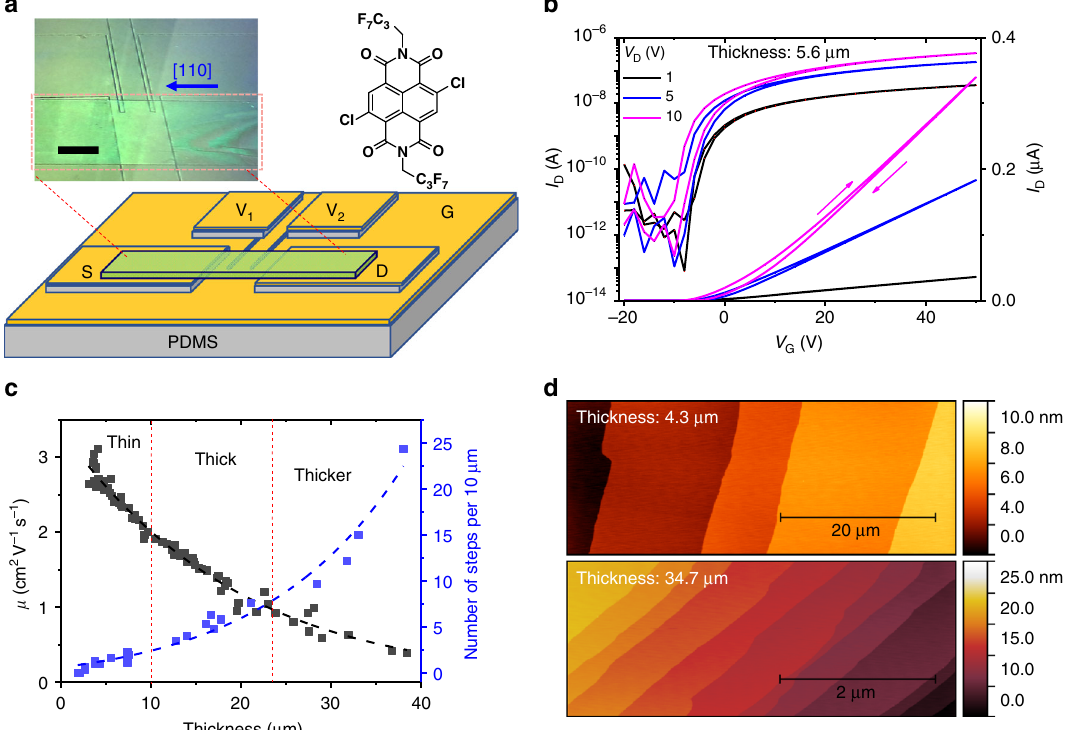
Fig. 1 Four-terminal FET measurements for Cl 2 -NDI single crystals with different thicknesses. a Schematic diagram of a four-terminal vacuum gap FET con fi guration on patterned PDMS substrate with a [110]-oriented Cl 2 -NDI single crystal. S, D, G represent source, drain, and gate electrodes, respectively. V 1 and V 2 are two voltage sensing channel electrodes. Inset: polarized light microscopy image of a device and chemical structure of Cl 2 -NDI. The black bar scale is 150 µ m. b Transfer curves ( I D - V G ) for single crystal FETs at different V D . The extracted electron fi eld effect mobility is ~2.7 cm 2 V − 1 s − 1 . The channel length and width are 150 and 200 µ m, respectively. The crystal thickness is 5.6 µ m. c Mobility of 78 crystals ( V D = 10 V) and step density at the surface of 24 crystals as a function of crystal thickness. The three regions (thin, thick, thicker) correspond to mobility >2 cm 2 V − 1 s − 1 with crystal thickness less than 10 µ m, 1 – 2 cm 2 V − 1 s − 1 with crystal thickness of 10 – 24 µ m and <1 cm 2 V − 1 s − 1 with crystal thickness exceeding 24 µ m, respectively. The number of steps is measured by atomic force microscopy (AFM) and counted along the direction of the crystal ’ s long axis ([110] direction). d AFM images of step density for single crystals with thicknesses of 4.3 µ m (top) and 34.7 µ m (bottom),